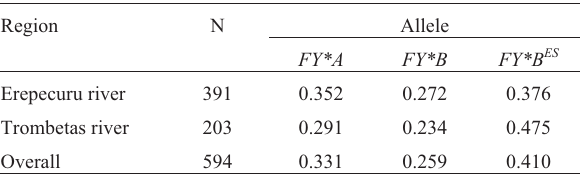
Table 2 - Duffy allele frequencies in Afro-descendant communities from Brazilian